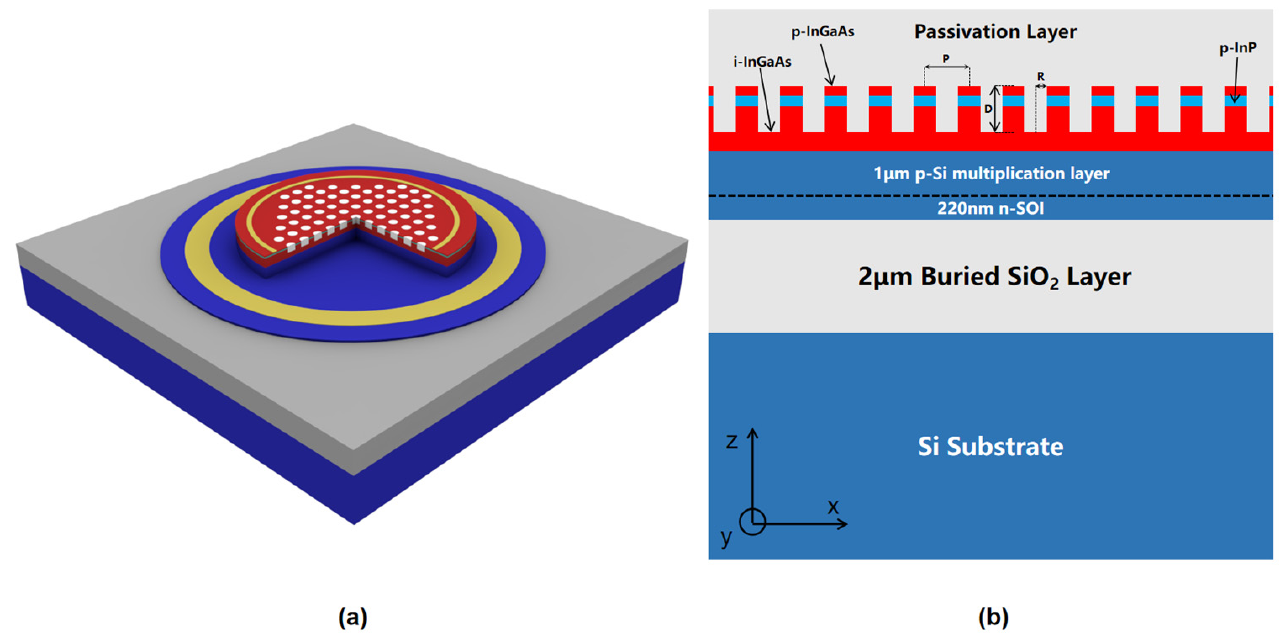
Figure 1. ( a ) 3D schematic of InGaAs/Si PT-APD; ( b ) cross-sectional diagram of the InGaAs/Si PT- APD.